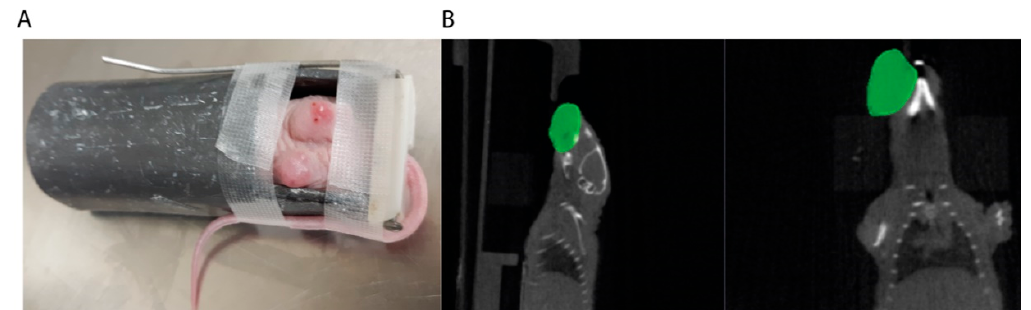
Figure 3. Radiation delivery to head and neck cancer (HNC) xenograft models. ( A ) Flank models, can be easily irradiated using cabinet irradiators and lead jigs. ( B ) Using an image-guided small animal irradiator, the tumor (contoured in green) can be targeted with multiple radiation beams to limit dose to other normal structures.